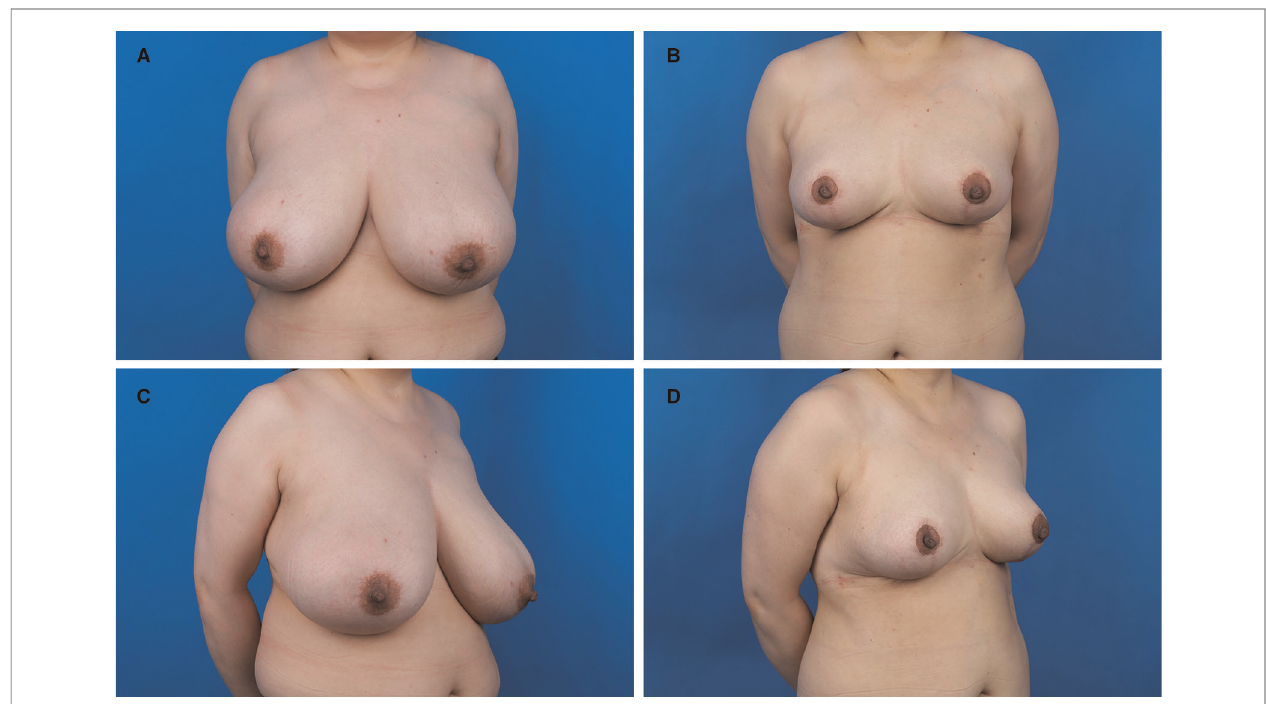
FIGURE 3 | Preoperative and postoperative views of the patient. ( A ) Preoperative frontal view. ( B ) Postoperative frontal view. ( C ) Preoperative anterior-oblique view. ( D ) Postoperative anterior-oblique